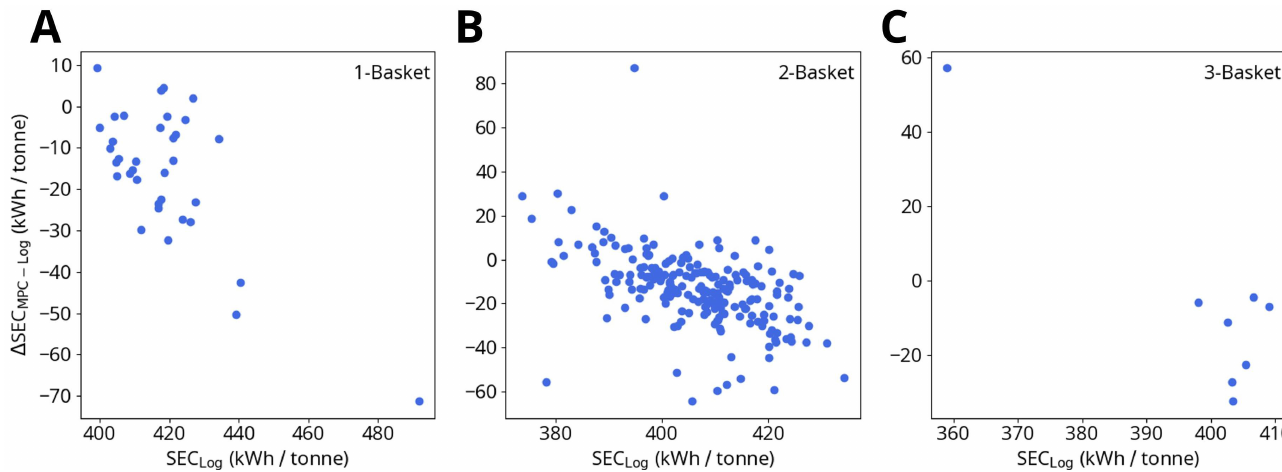
Figure 10. Logged specific energy consumption (SEC) up to the point of melting vs. change in SEC due to MPC for ( A ) one-basket heats, ( B ) two-basket heats and ( C ) three-basket heats. ∆ SEC is calculated as described in Figure